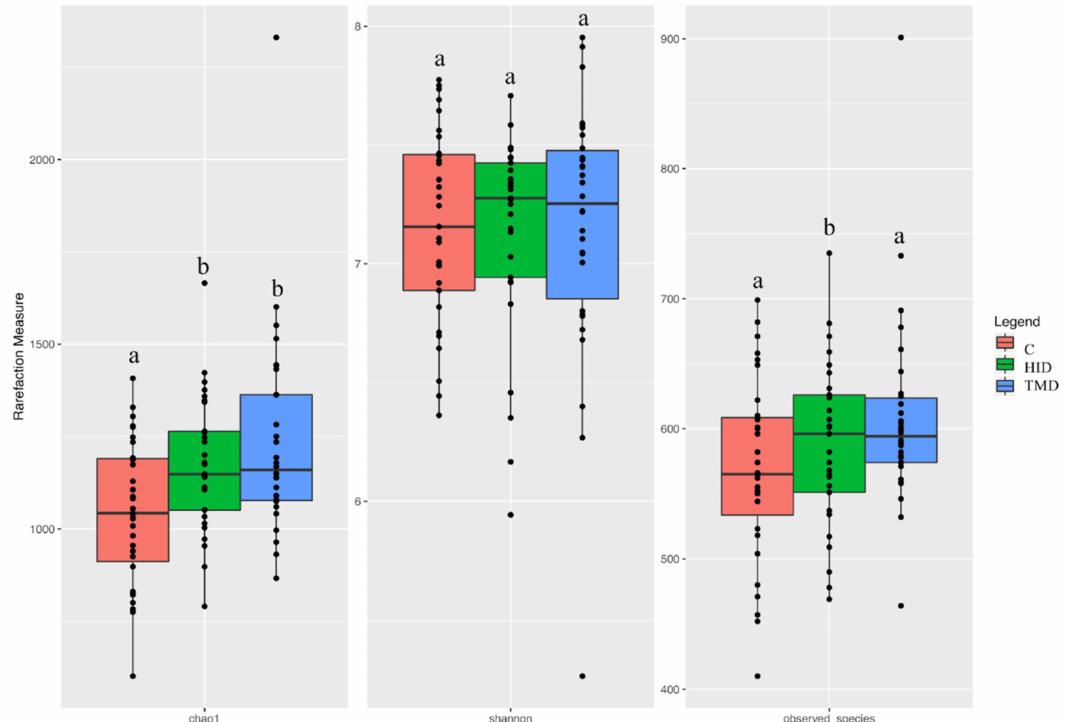
Figure 1. Boxplots showing the alpha diversity rarefaction index across fecal samples of rabbits fed with TMD (blue box), HID (green box), or C (red box) diets; C: control diet with soybean oil; HID: diet with Hermetia illucens fat; TMD: diet with Tenebrio molitor fat; Boxes represent the interquartile range (IQR) between the first and third quartile and the line inside represents the median (2nd quartile). Whiskers denote the lowest and the highest values within 1.56 IQR from the first and third quartile, respectively. Di ff erent letters in each box indicate significant di ff